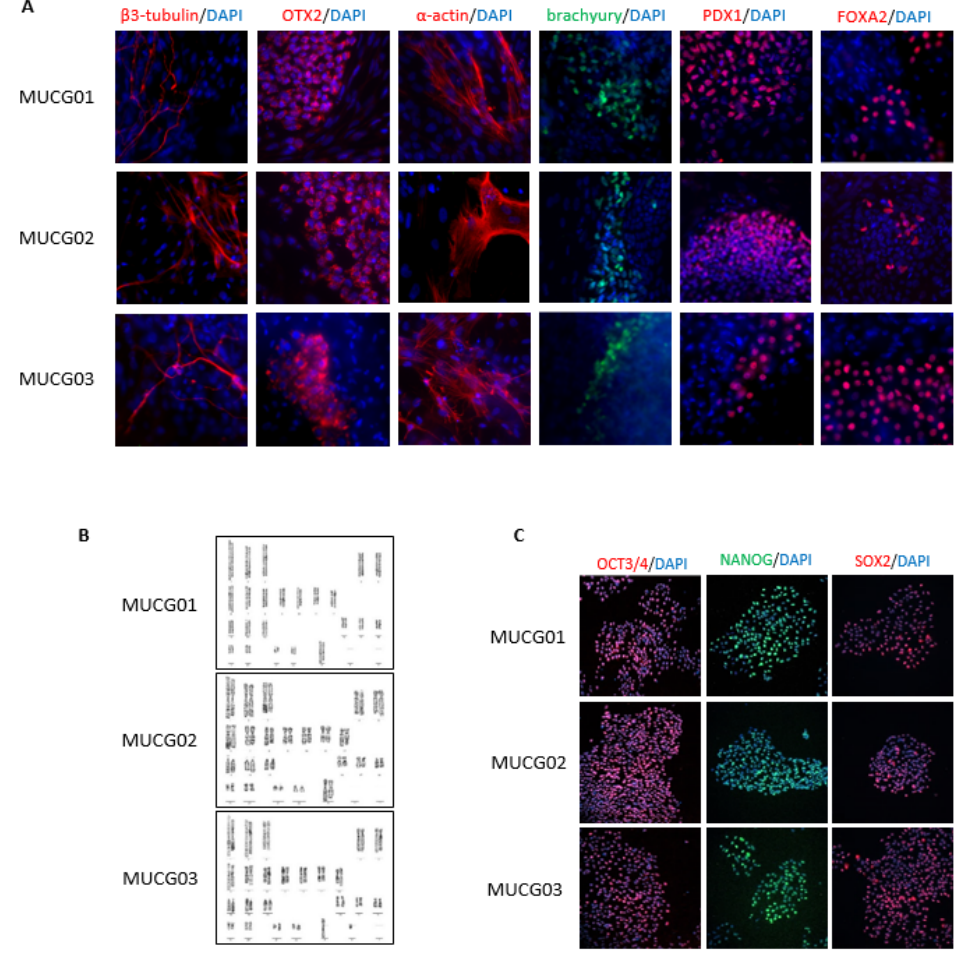
Figure 3. ( A ) Differentiation markers for the endoderm (FOXA2, PDX1), mesoderm ( α -actin, brachyury), and ectoderm ( β 3 Tubulin, Otx2) were detected for the MUCG01, MUCG02, and MUCG03 clinical-grade hESC lines by immunocytochemistry. ( B ) Standard karyotypes without chromosomal aberration were detected for all hESC lines MUCG01: 46,XX; MUCG02: 46,XX; and MUCG03: 46,XY. ( C ) Pluripotency markers Oct3/4, Sox2, and Nanog were detected for the MUCG01, MUCG02, and MUCG03 clinical ‐ grade hESC lines by immunocytochemistry.